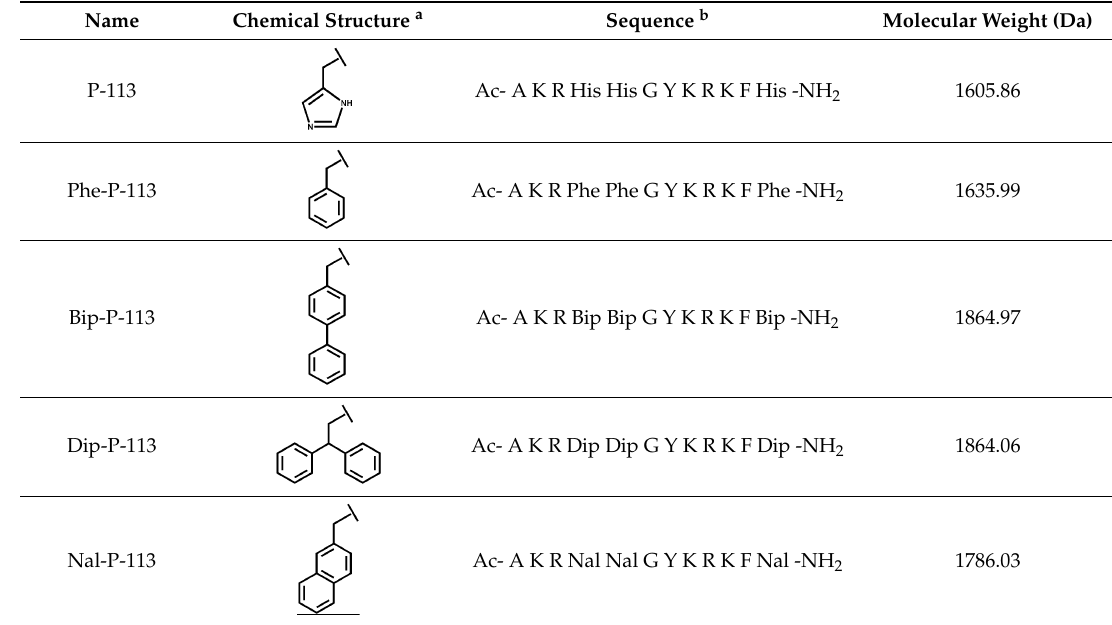
Table 1. Sequences of P-113, Phe-P-113, Bip-P-113, Dip-P-113 and Nal-P-113.